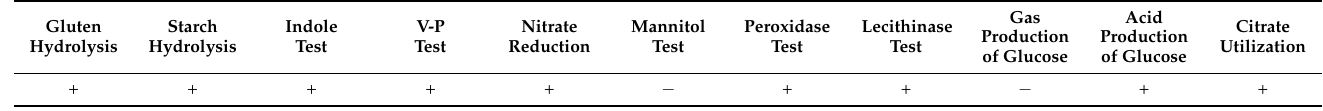
Table 1. Biochemical characteristics of the isolated Bacillus cereus